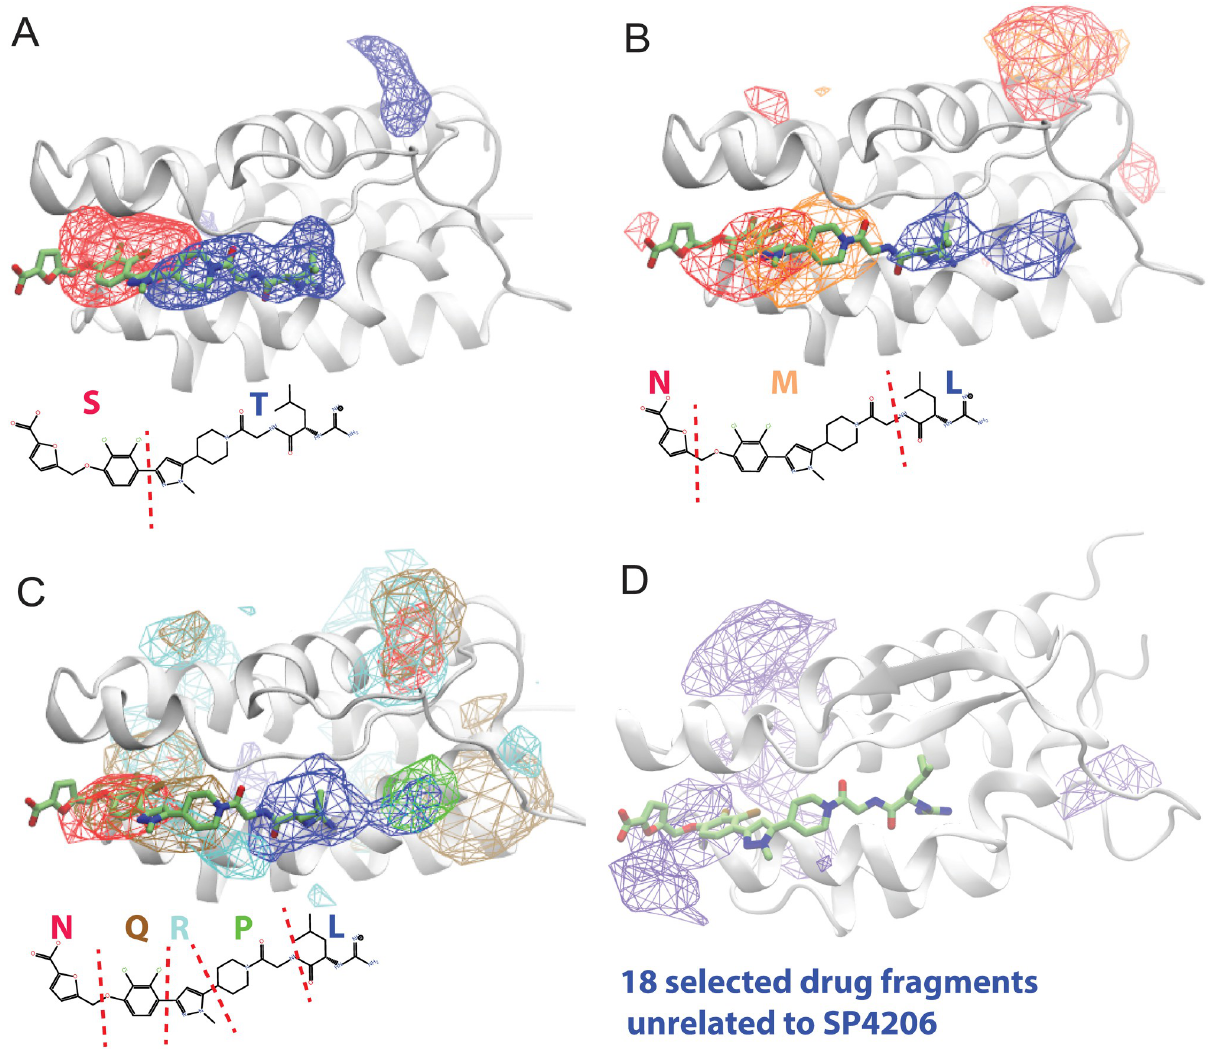
Fig 5. Binding of fragments of SP4206 to IL2. The occupancy density maps of fragments of SP4206: S and T in (A) based on a 54- μ s simulation; N, M, L in (B) based on a 37- μ s simulation; and N, Q, R, P, L in (C) based on a 16- μ s simulation. In (D), the occupancy density of 18 common drug fragments unrelated to SP4206 is shown, based on a 16.5- μ s simulation. The native binding pose of SP4206 is shown, to mark the cryptic binding site and to indicate the locations of the fragments relative to a bound SP4206 molecule.